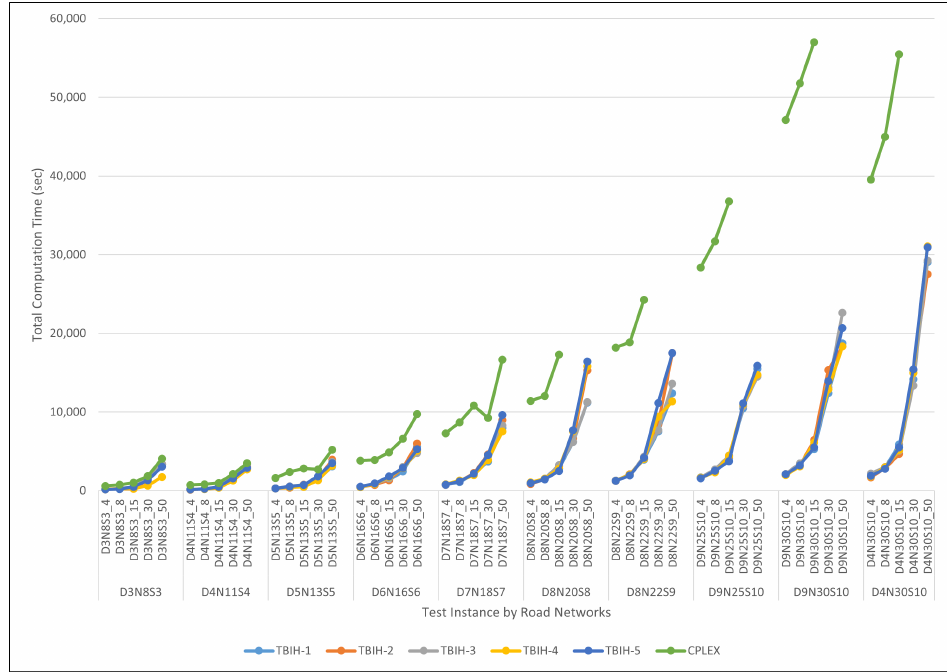
Figure A18. Algorithms performance compared to matheuristic rollout applied in PDS-RA: best total computation time (sec) measured based on test instances.